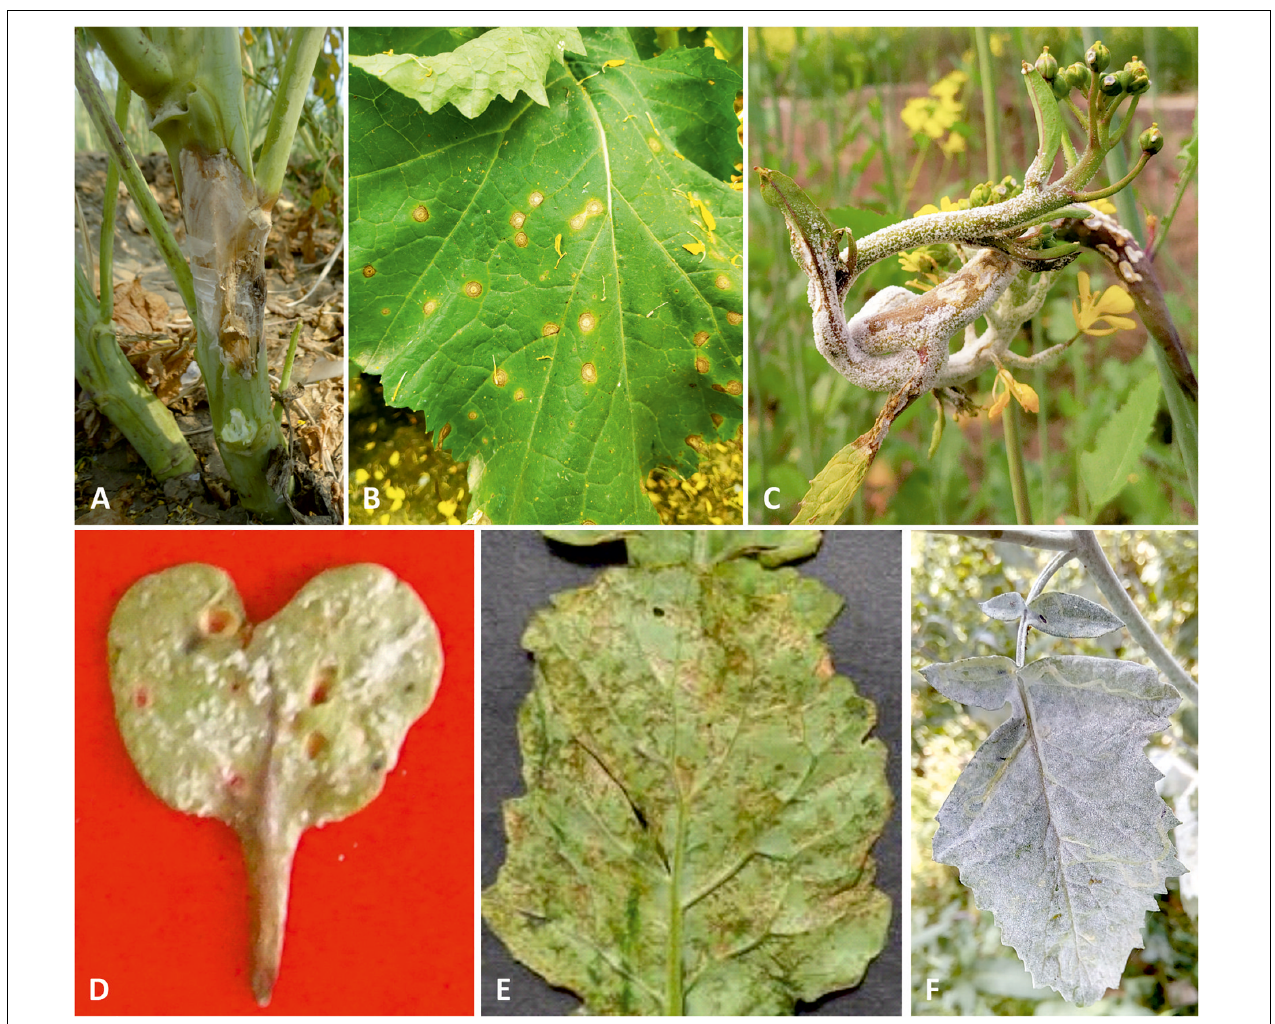
FIGURE 1 | Major fungal diseases of B. juncea . (A) Sclerotinia stem rot; (B) Alternaria leaf blight; (C) Staghead formation in flower buds of B. juncea by A. candida ; (D,E) Downy mildew symptoms at lower surface of cotyledon and mature leaf, respectively (Photo courtesy: A. K. Tewari); (F) Powdery mildew of B. juncea